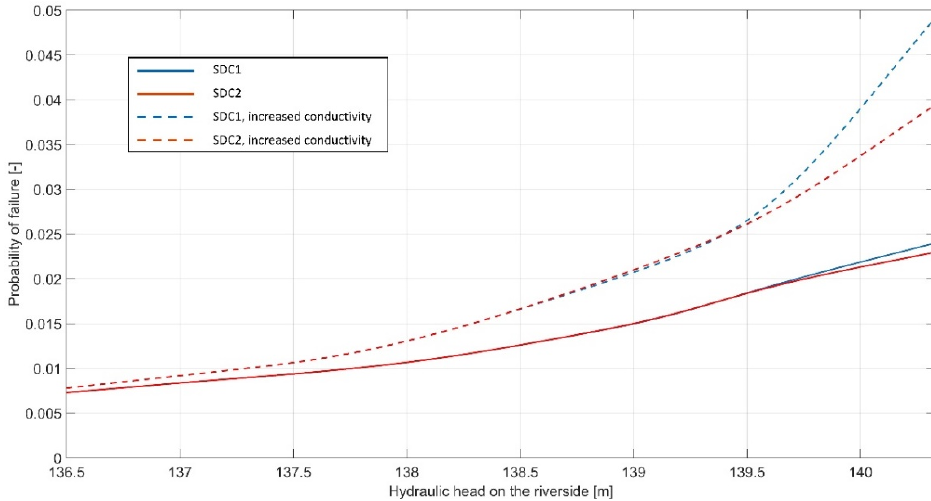
Figure 8. Fragility curves for transient seepage of 5-day duration.